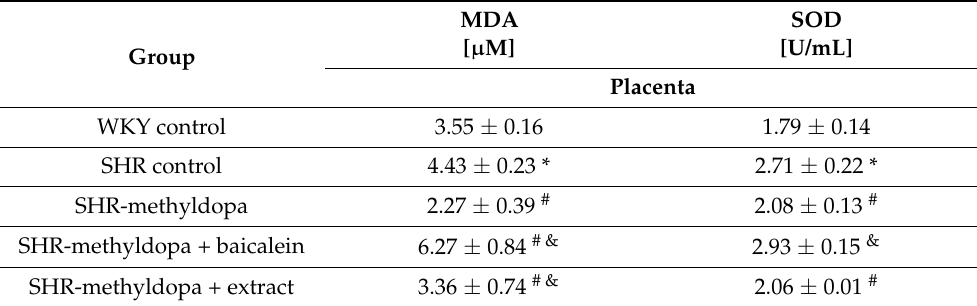
Table 3. Influence of methyldopa and its combination with baicalein or extract from Scutellaria baicalen- sis roots on levels of selected factors related to oxidative stress (malonyldialdehyde concentration and activity of superoxide dismutase) in placenta of SHR pregnant rats. MDA SOD Group Placenta WKY